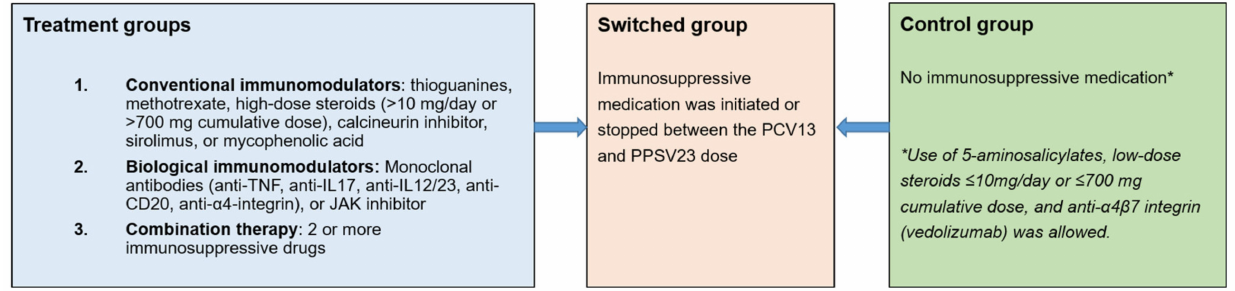
Figure 1. Study groups. TNF = tumor necrosis factor, IL = interleukin, JAK = Janus kinase, PCV13 = 13- valent pneumococcal conjugate vaccine, PPSV23 = 23-valent pneumococcal polysaccharide